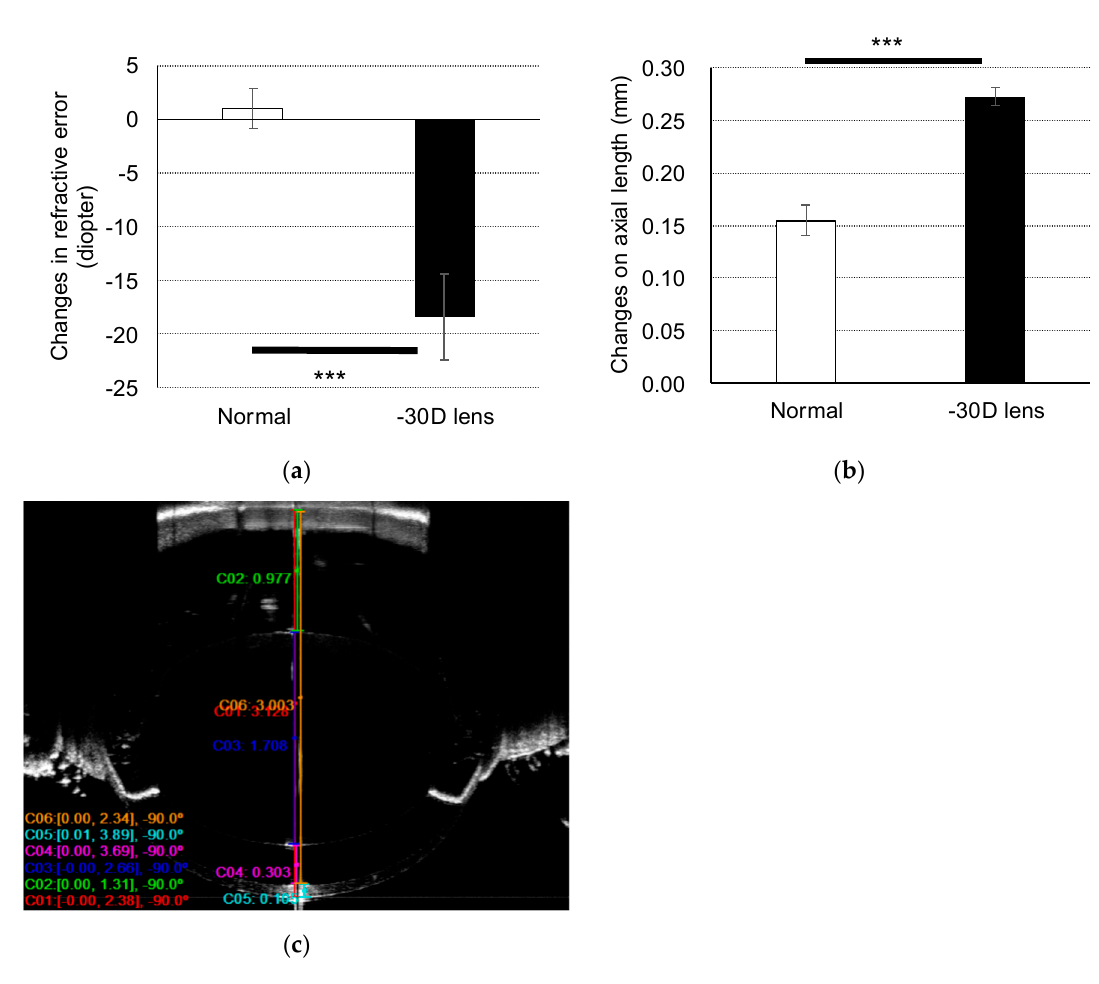
Figure 1. Myopia induction in mice using a negative 30 diopter (D) lens. Changes in ( a ) refraction and ( b ) axial length over three weeks are shown as a comparison between normal and negative 30 D lens-wearing eyes ( n = 3). Data are presented as the mean ± SD. *** p < 0.001; Student’s t -test. ( c ) A representative optical coherent tomography (OCT) image showing each ocular